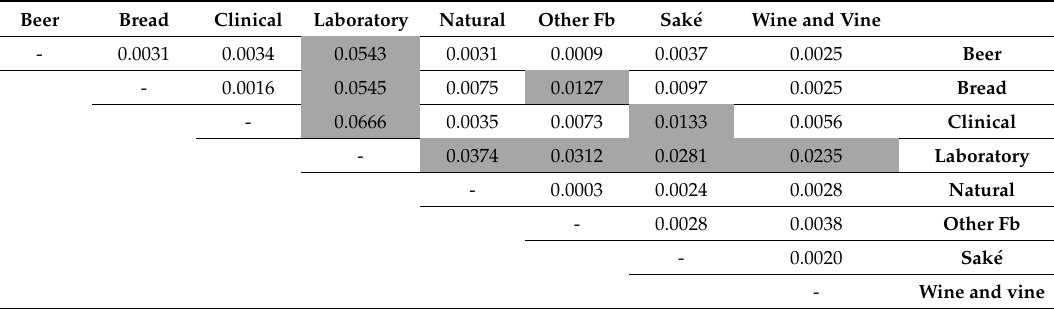
Table 2. Fst statistics calculated using DNAsp between each group of strains, categorized according to their technological source, using mtDNA genomic data. Values higher than 0.01 are highlighted. Other Fb—other fermented